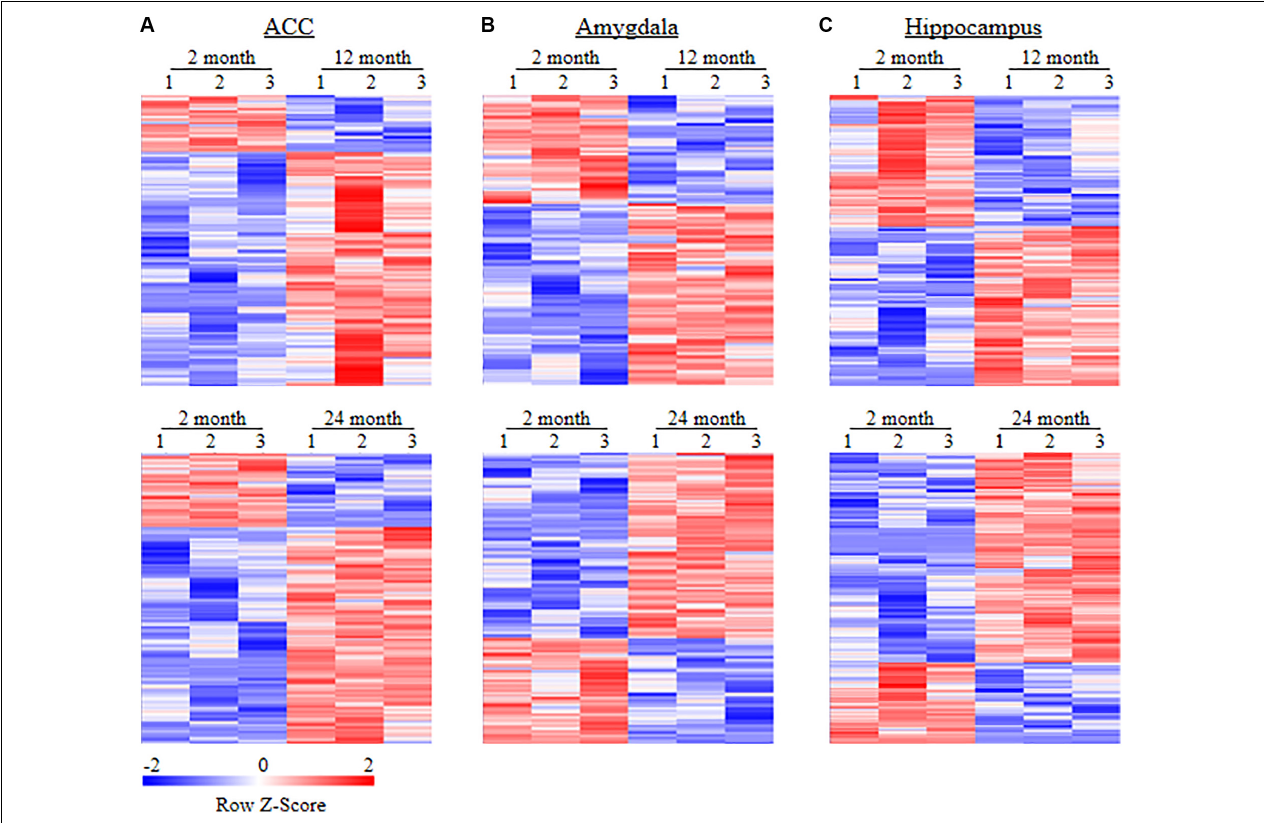
FIGURE 4 | Heatmaps of differentially expressed genes (DEGs) in the ACC (A) , amygdala (B) and hippocampus (C) from 2-month old mice versus 12-month old mice (top) or 24-month old mice (bottom). Colors in the heatmaps indicate the Row Z -score among the different data sets. High expression is shown by the red color spectrum, and low expression is shown by the blue. N = 3 biological repeats (3 mice)/age.